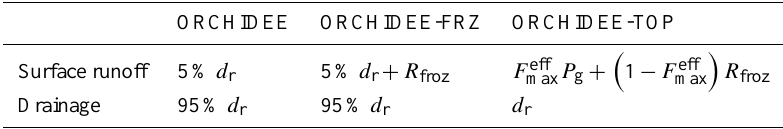
Table 1. Ways to compute surface runoff and drainage in the different ORCHIDEE versions. d r is the overflow runoff, simply defined as the excess water when the soil is over its maximum